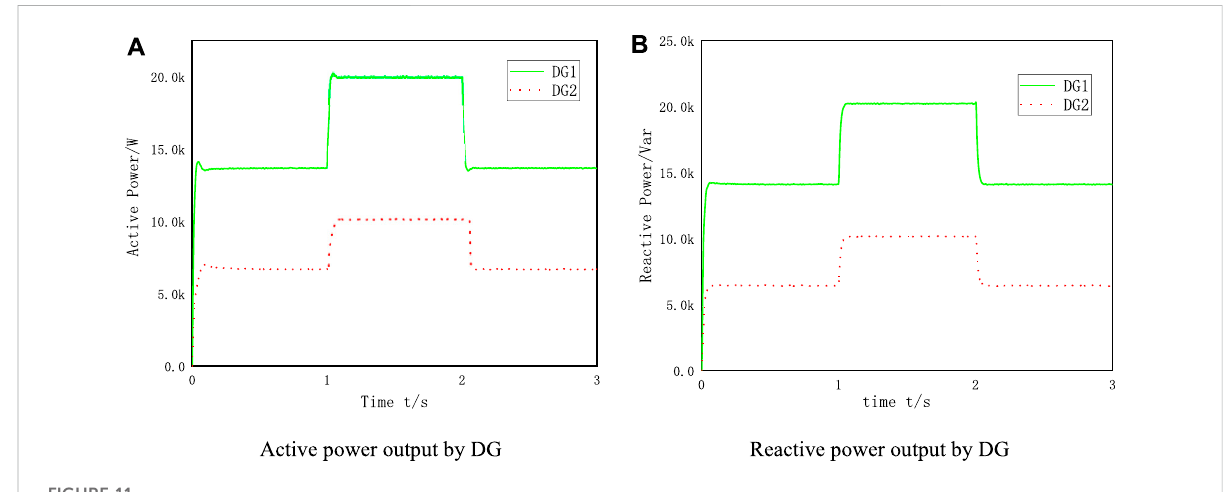
FIGURE 11 Simulation resultsofimprovingdroopcontrolwithtwoDGswithdifferentcapacities. (A) ActivepoweroutputbyDG. (B) Reactive poweroutput by